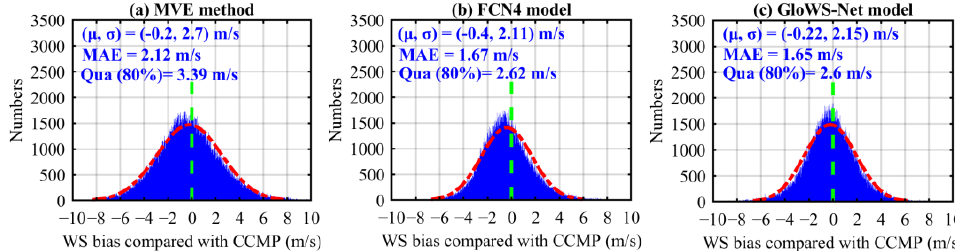
Figure 12. Deviation distribution histograms between CCMP wind speed and retrieved wind speed by different models.